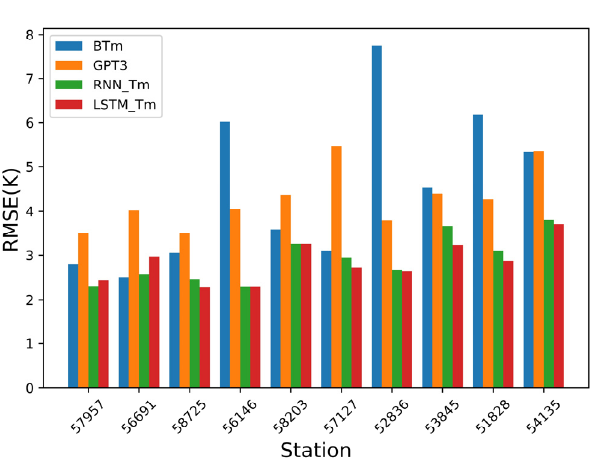
Table 5. RMSE of four models at different stations [K].